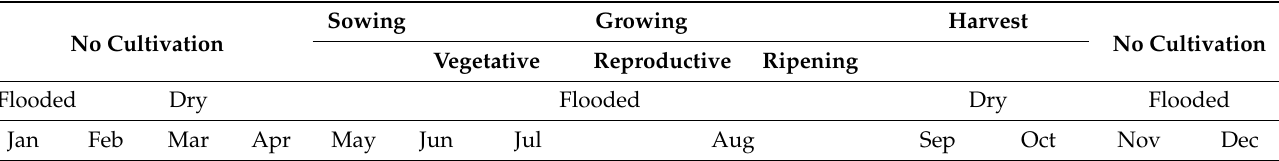
Table 1. Timing of the main phenological stages of rice in Valencia.